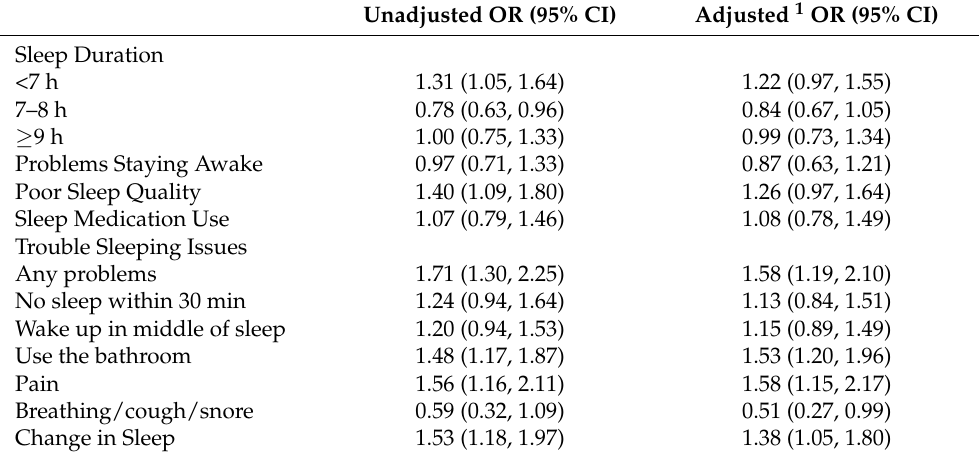
Table 3. Association of sleep quality among rectal cancer patients compared to colon cancer patients (N =